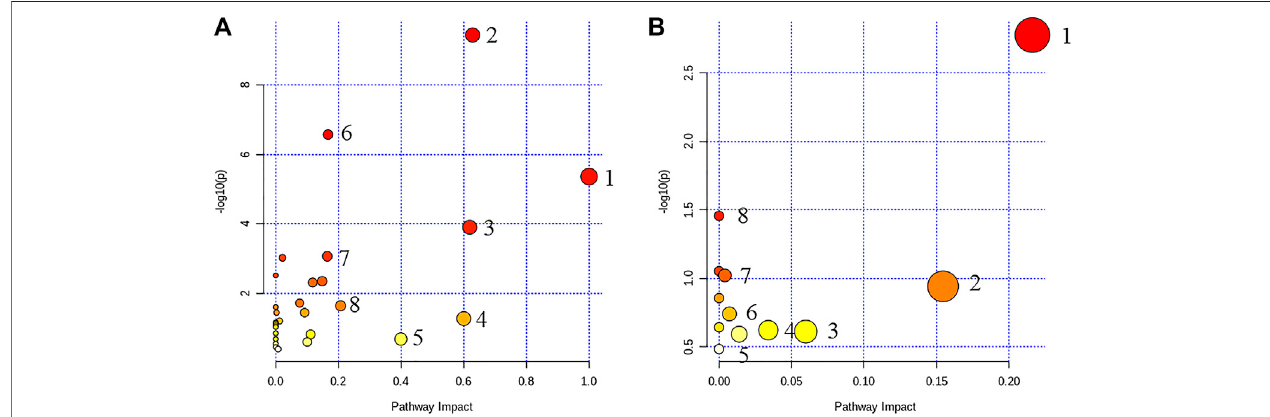
FIGURE 2 | Overview of metabolic pathway analysis ( A , clinical sample): 1) phenylalanine metabolism, 2) glycine, serine, and threonine metabolism, 3) retinol metabolism, 4) synthesis and degradation of ketone bodies, 5) beta-alanine metabolism, 6) aminoacyl-tRNA biosynthesis, 7) tyrosine metabolism, and 8) pyruvate metabolism; ( B , plasma samples in mice): 1) glycine, serine, and threonine metabolism, 2) retinol metabolism, 3) pyrimidine metabolism, 4) arginine and proline metabolism, 5) tryptophan metabolism, 6) glutathione metabolism, 7) glycosyl phosphatidyl inositol (GPI) – anchor biosynthesis, and 8) sphingolipid